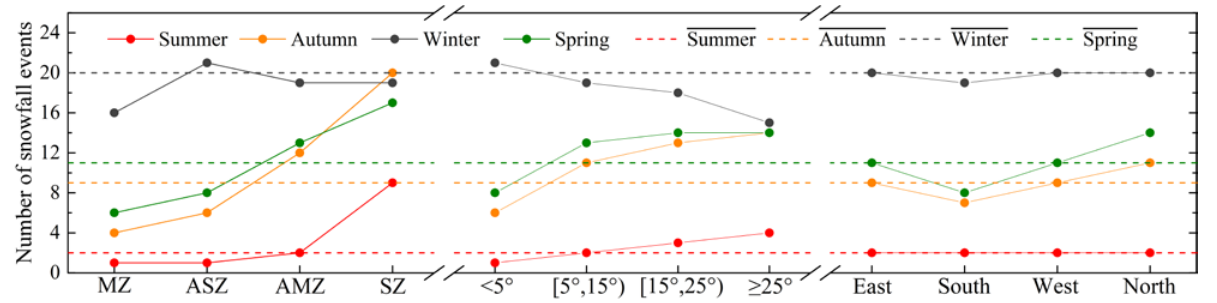
Figure 10. Seasonal frequency of snowfall at each elevation zone, slope angle, and slope aspect over the Kaidu River Basin from June 2000 to May 2020. Solid lines are the median snowfall at each elevation zone, slope angle, and slope aspect. Dashed lines are the median snowfall in the four seasons of the study area. MZ = montane zone, ASZ = alpine steppe zone, AMZ = alpine meadow zone, and SZ = snow zone.